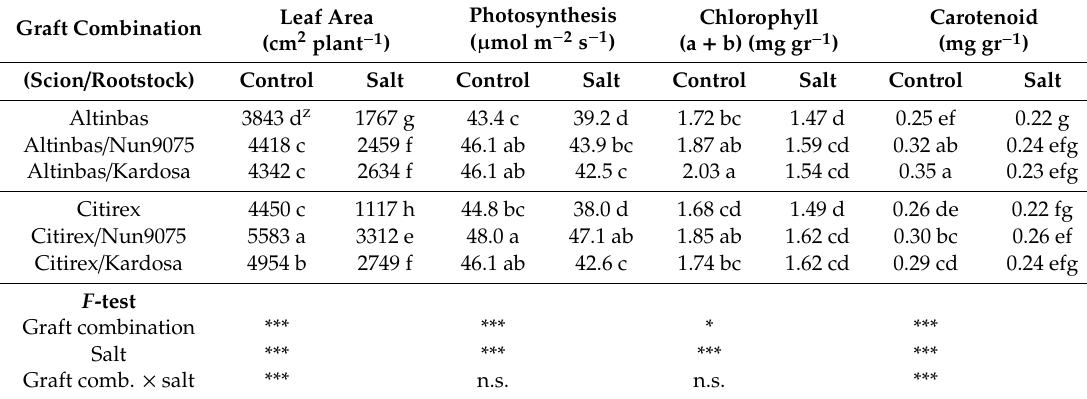
Table 2. Leaf area, photosynthesis, chlorophyll content (a + b), and carotenoid content of melon